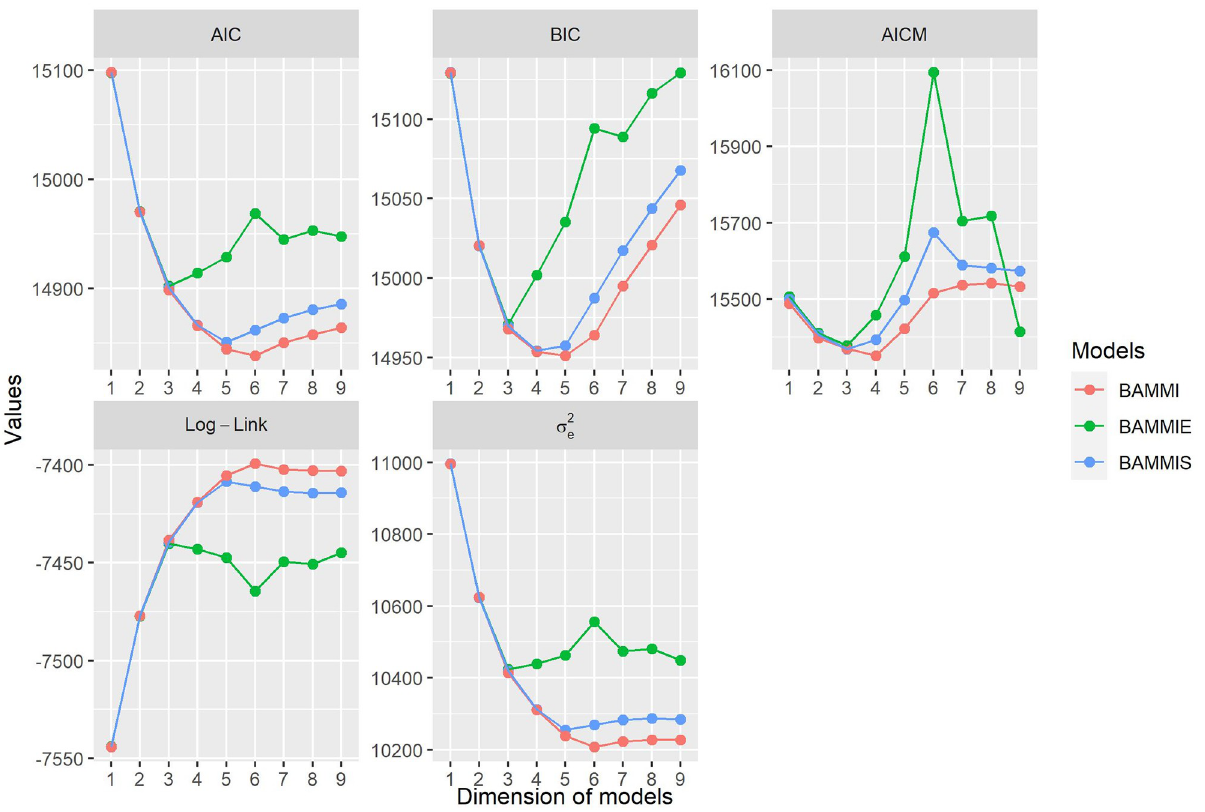
Fig 15. Ockham’s plot for the BAMMI, BAMMIS, and BAMMIE models for the AIC, AICM, and BIC information criteria for real data. The behaviors of log-likelihood (log-like) and residual variance ( σ e 2 ) are also presented.